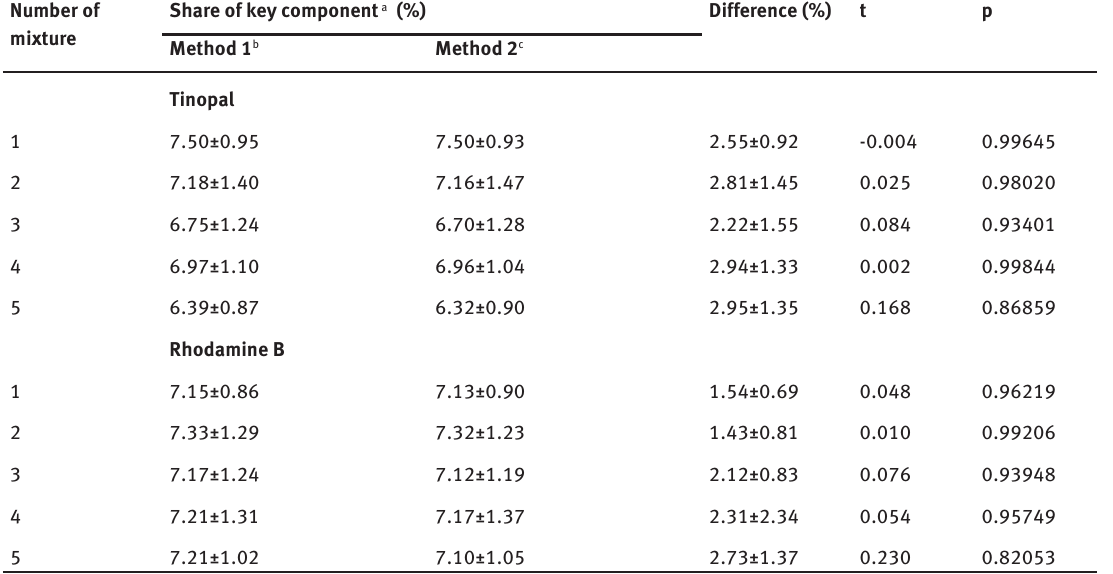
Table 3: Percentage content of the key component and the results of Student’s t-tests at α=0.05. Number of